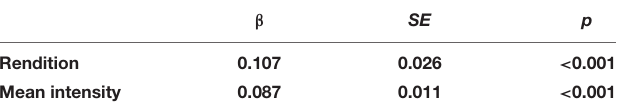
TABLE 4 | Fixed effect estimates for the best-fitting models of performance for the analysis of the arousal data for the older adults only; bold indicates significant results, number of observations = 816, AIC = 804.6.